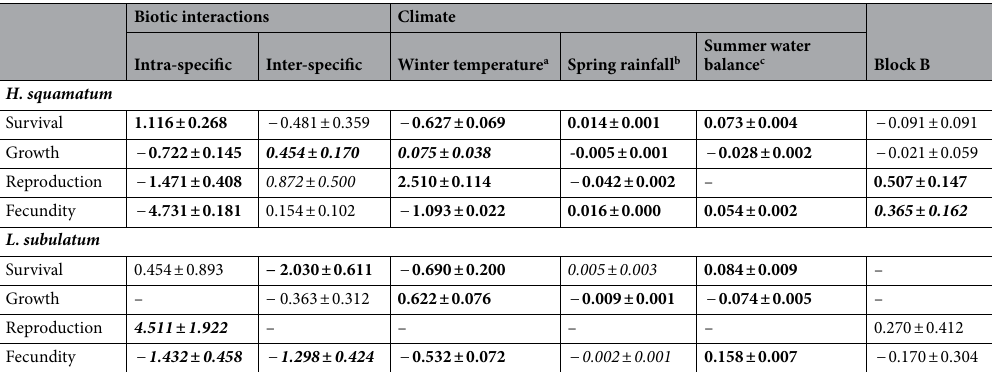
Table 1. Coefficients ± standard error of fixed explanatory variables (excluding size) considered in the most informative GLMMs for vital rates of the study species. a Averaged minimum temperature from December to February. b Accumulated rainfall from February to May. c Water balance (accumulated precipitation − 2 * temperature) from June to September. Significant coefficients at P < 0.001 and P < 0.05 are highlighted in bold and in bold italics, respectively. Marginally significant coefficients ( P < 0.1) are in